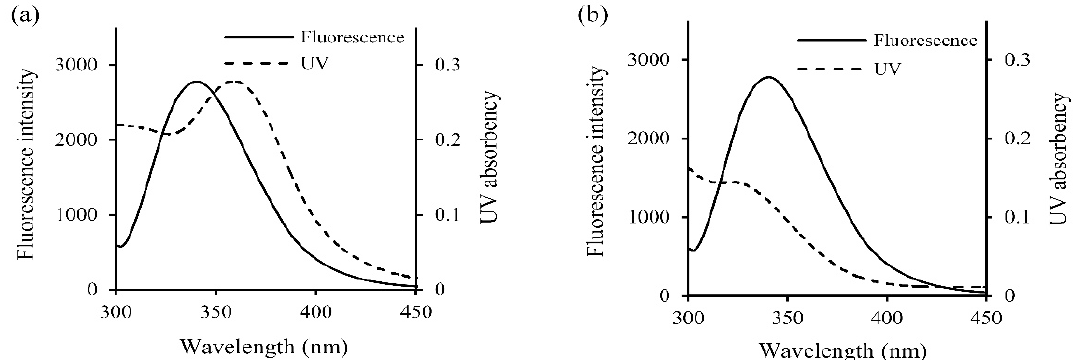
Figure 2. Overlap features of the fluorescence emission spectra of WPI and ultra ‐ violet (UV) absorption spectra of galangin ( a ) or genistein ( b ). Both WPI and galangin/genistein were used at 20 μ mol/L. Table 4. The energy transfer parameters for the non-covalent WPI-galangin / genistein interactions. Protein-Polyphenol Complex J (cm3 · L / mol) R0 (nm) E WPI-galangin